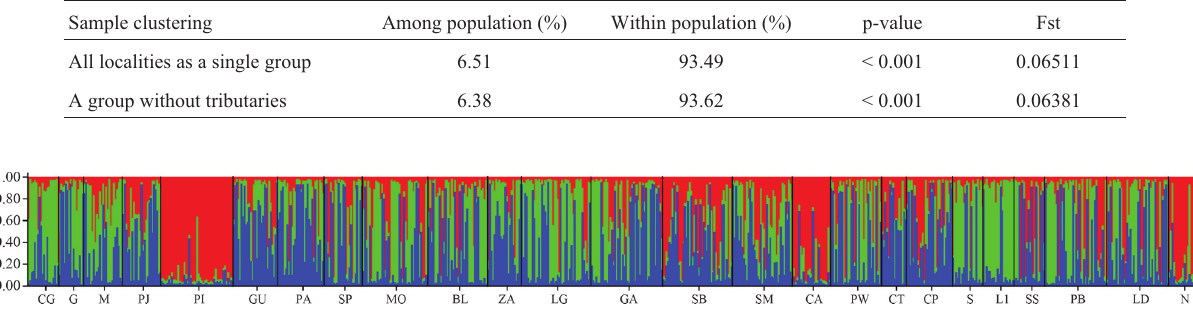
Figure 2 - Estimated population structure for P. magdalenae . Barr plot of the highest probability run at K = 3. Each individual of P. magdalenae is repre- sented by a vertical bar whose color (blue, red or green) indicates the coefficient of relationship (scale at left) to each cluster. The names of each locality sampled are indicated above. Sampling sites: CG: Ciénaga Grande, PA: Palomino, MO: Mompós, PI: Pijiño, PJ: Pajarales, GU: Guacamayal, ZA: Zapatosa, BL: Barranco de loba, LG: La Gloria, GA: Gamarra, PW: Puerto Wilches, CT: Canta Gallo, CP: Paredes, SS: San Silvestre, LI: Llanito, PB: Puerto Boyacá, LD: La Dorada, N: Neiva, G: Gambote, M: Mahates, CA: Cauca, SP: Santa Paula, SO: Sogamoso, SM: San Marco, SB: San